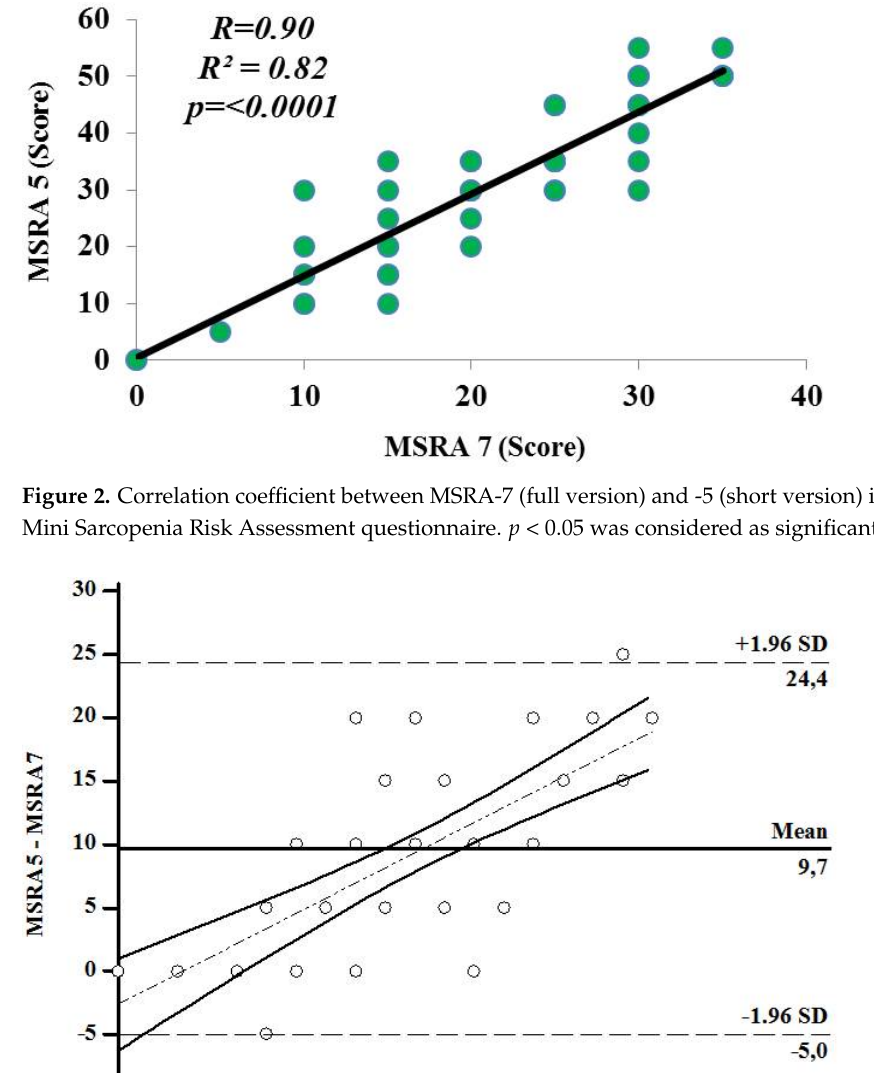
Figure 1. Correlation between calf circumference and Mini Sarcopenia Risk Assessment Questionnaire (MSRA) of 5 (short version, A ) and 7 (full version, B ) items. p < 0.05 was considered as significant.